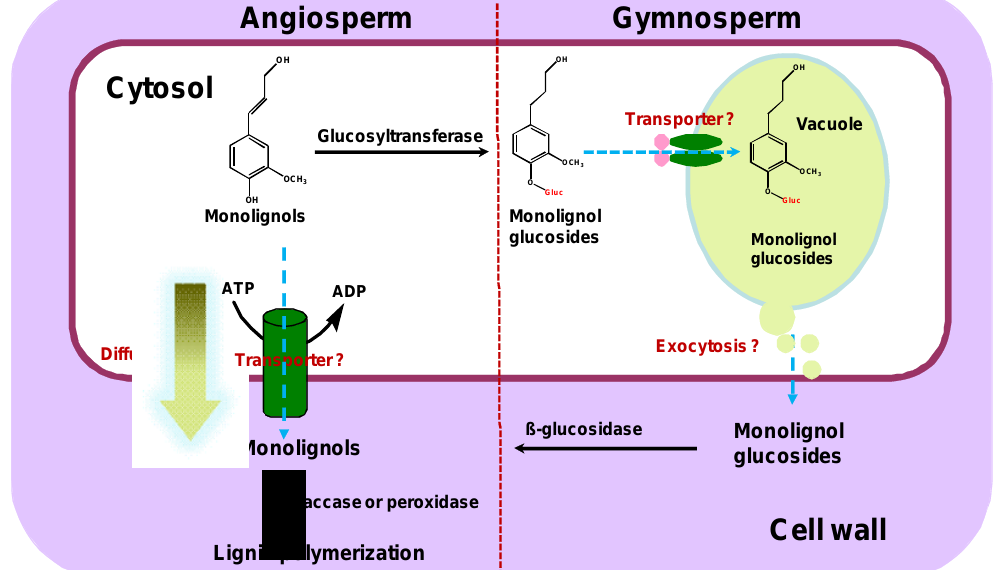
Figure 1. Alternative models or pathways of monolignol transport in angiosperms and